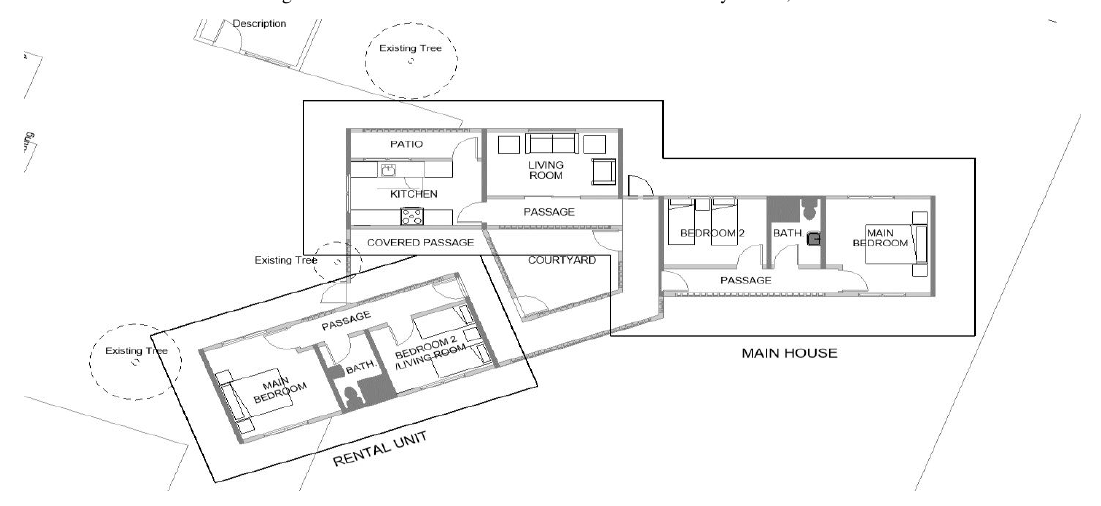
Figure 14: Scenario 2: One main house with two bedrooms and one rental unit. By author, 2022.